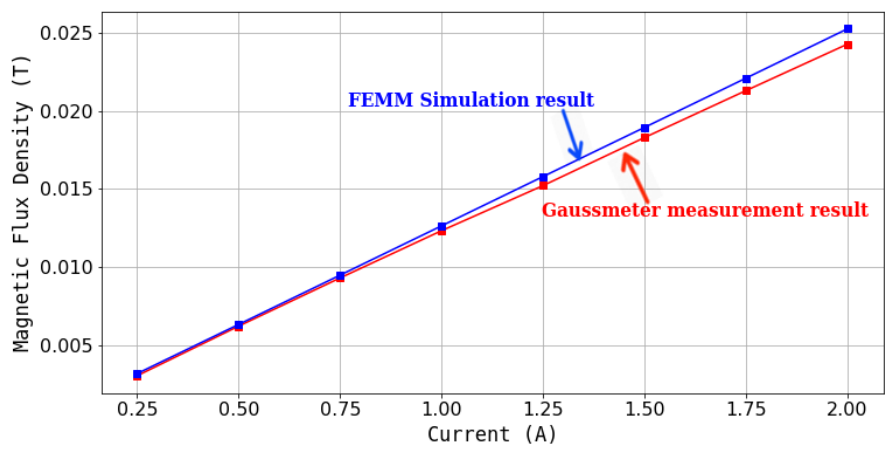
Figure 3. Comparison Results of Gaussmeter Measurement and FEMM Simulation.